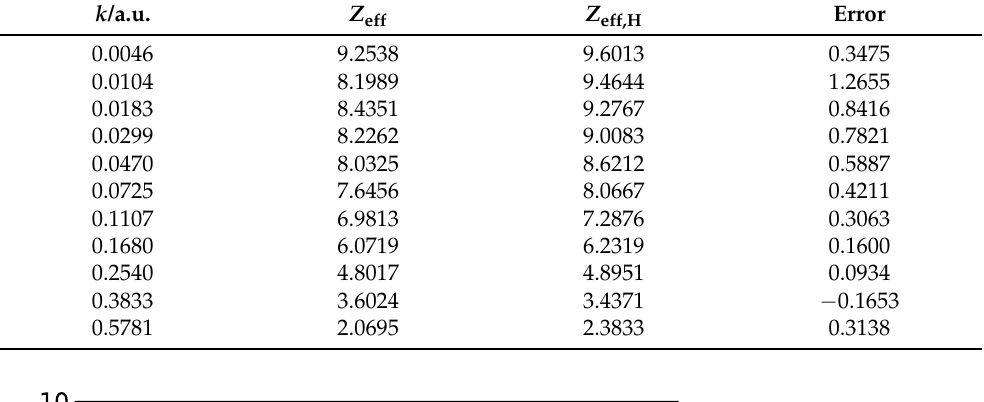
Table 3. Z eff values obtained using a wavefunction with nine nonzero γ i terms (Appendix B) to describe electron–positron correlations and the benchmark results from [26] ( Z eff,H ) interpolated to the same values of momentum.